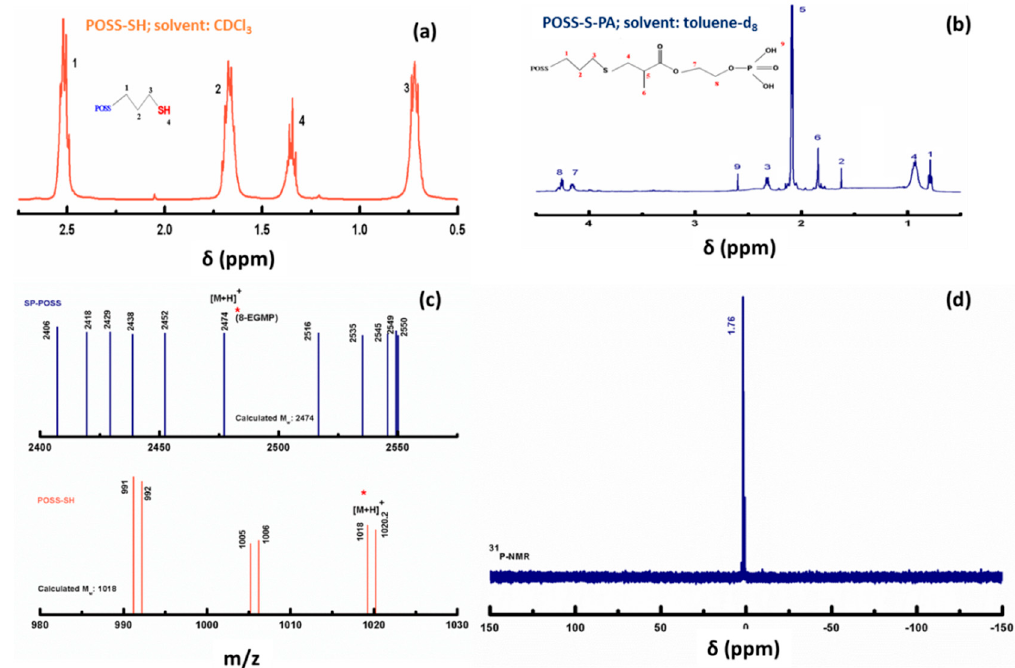
Figure 2. ( a ) 1 H-NMR spectrum of POSS-SH; ( b ) 1 H-NMR spectrum of POSS-S-PA; ( c ) MALDI-TOF-MS 1 Figure 2. ( a ) H-NMR spectrum of POSS-SH; ( b ) spectrum of POSS-SH and POSS-S-PA; ( d ) 31 P-NMR spectrum of MALDI-TOF-MS spectrum of POSS-SH and POSS-S-PA; ( d )